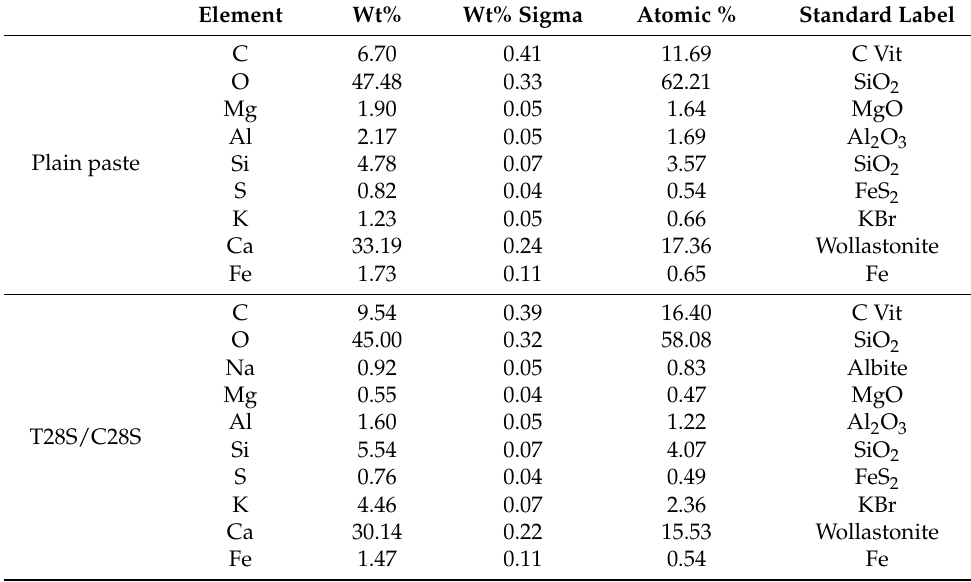
Table 8. Elemental analysis from EDS